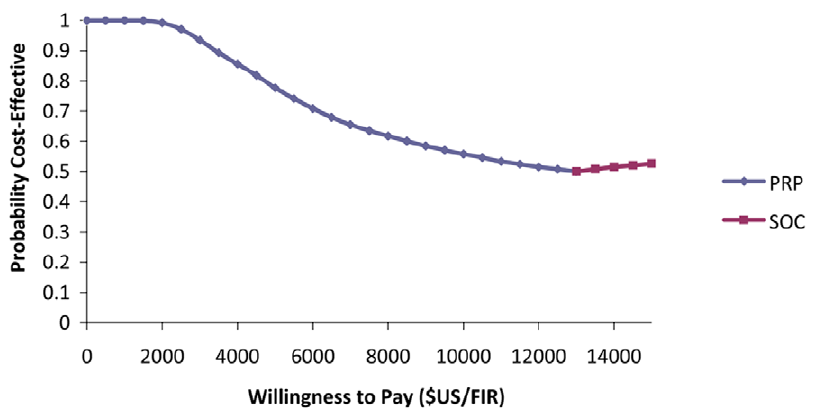
Figure 3. Cost-effectiveness acceptability curve showing the probability that Pharmacy-only Refill Program (PRP) or Standard of Care (SOC) is cost-effective compared to the other over a range of values of willingness to pay.